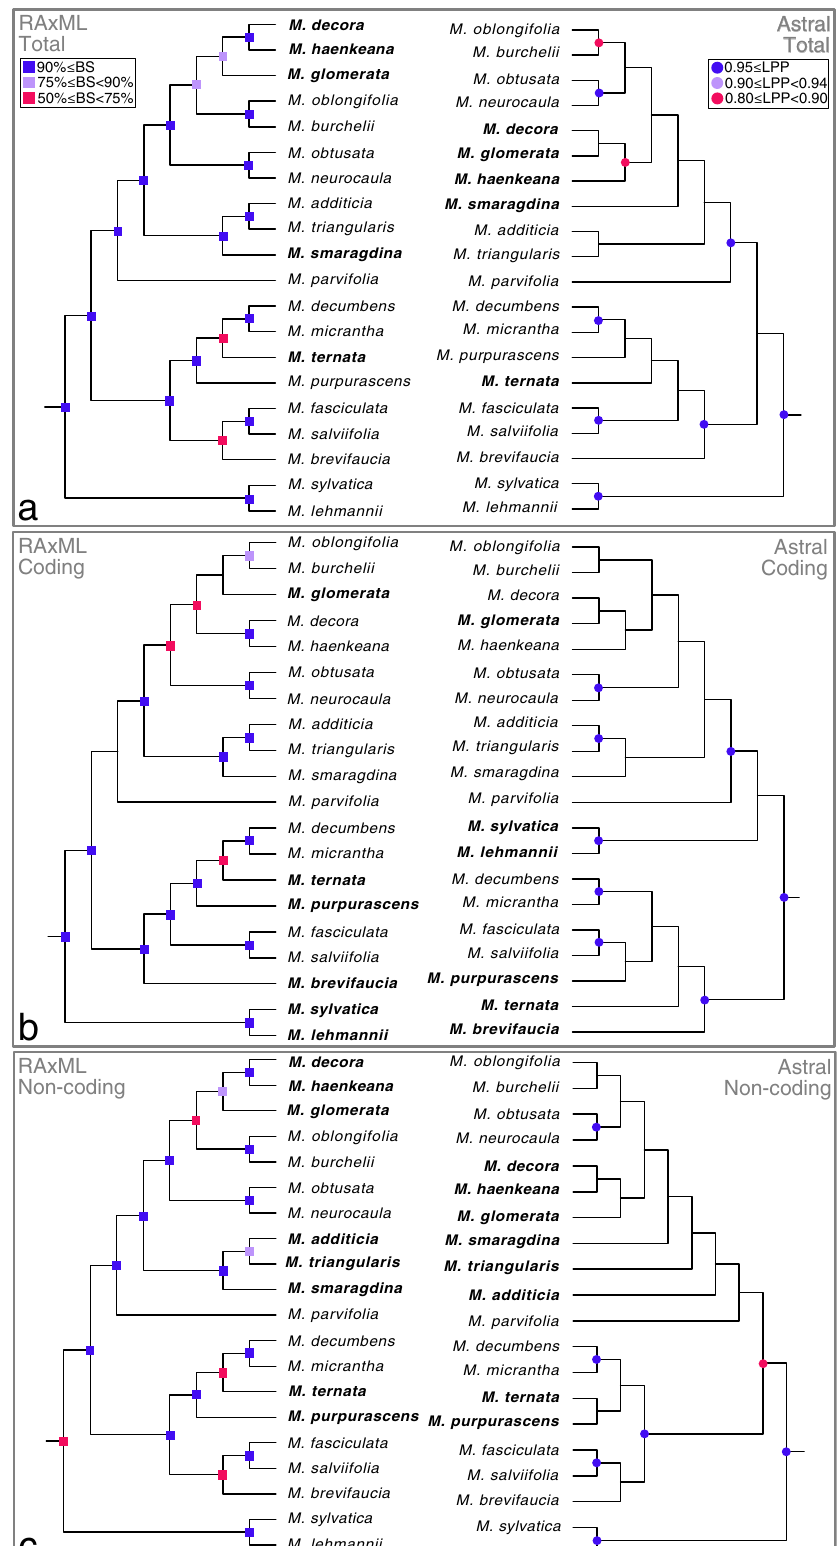
Figure 2. Phylogenetic analyses of Mikania using different data partitions and inference methods. RAxML refers to concatenate maximum likelihood analyses and Astral refers to multispecies coalescent inference. Support values are color- coded and nodes without symbols correspond to unsupported branches (BS < 50%, LPP < 0.8). ( a ) Analyses carried out with the whole plastome sequence with one of the IRs removed. ( b ) Analyses conducted only with the coding regions (CDS) of the plastome. ( c ) Analyses carried out only with non-coding regions of the plastome (intergenic regions and